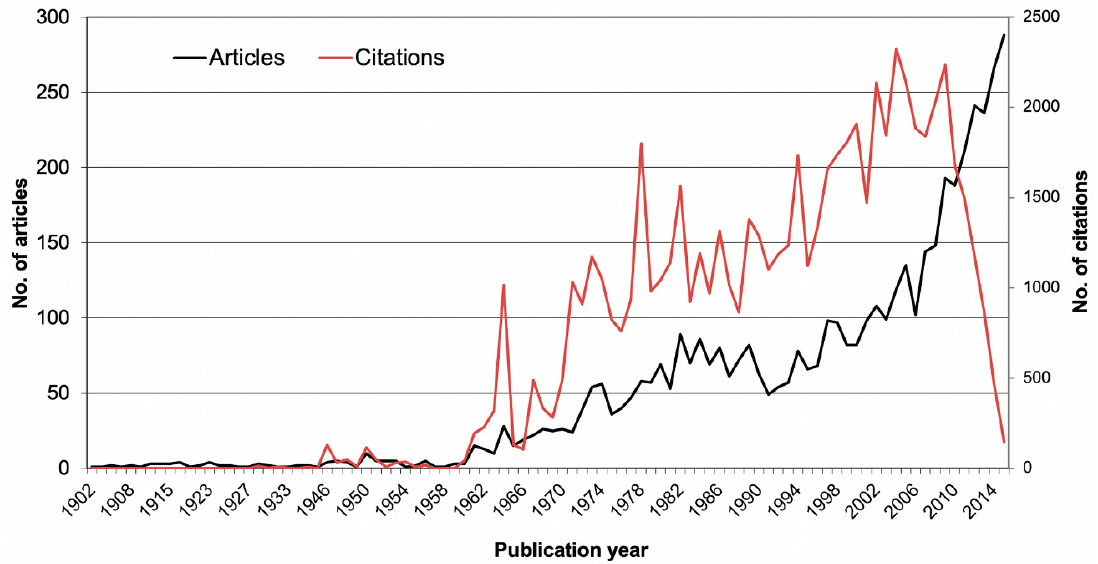
Figure 1. Number of articles and citations over time. The most frequently cited articles on oral hygiene are shown in Table